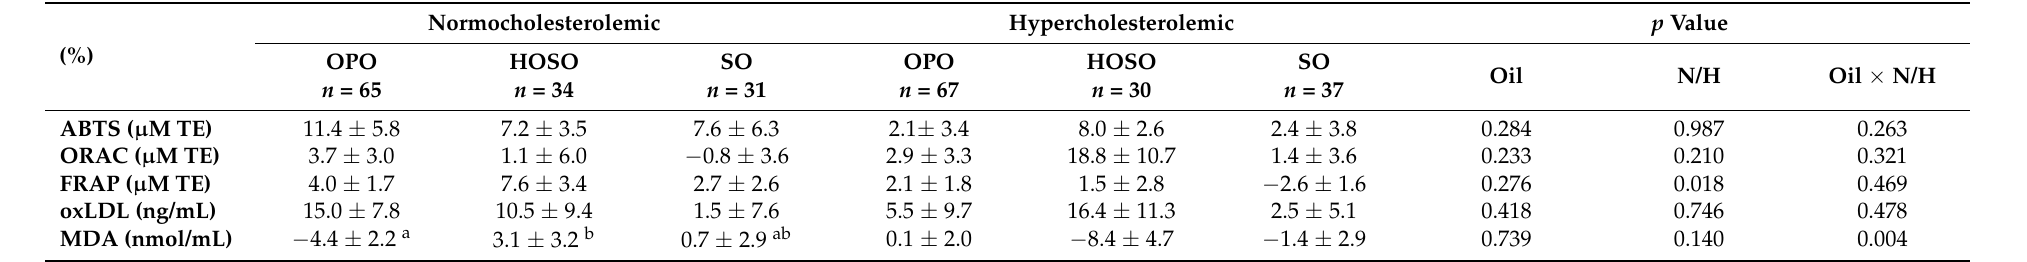
Values represent mean ± standard error of mean. The rate of change was calculated from [(post-treatment value − pre-treatment value)/pre-treatment value] and expressed as percentage. A linear mixed model was used for data analysis. p -value in the first column represents the treatment effect (OPO, HOSO or SO), in the second column the group effect [normocholesterolemic (N) and hypercholesterolemic (H)], and in the last column the interaction of treatment and group. Significance level was set at p < 0.05. ABTS: free radical 2,2 (cid:48) -azinobis-(3-ethylbenzothiazoline-6-sulfonic acid)-scavenging capacity. ORAC: oxygen radical absorbance capacity. FRAP: ferric reducing/antioxidant